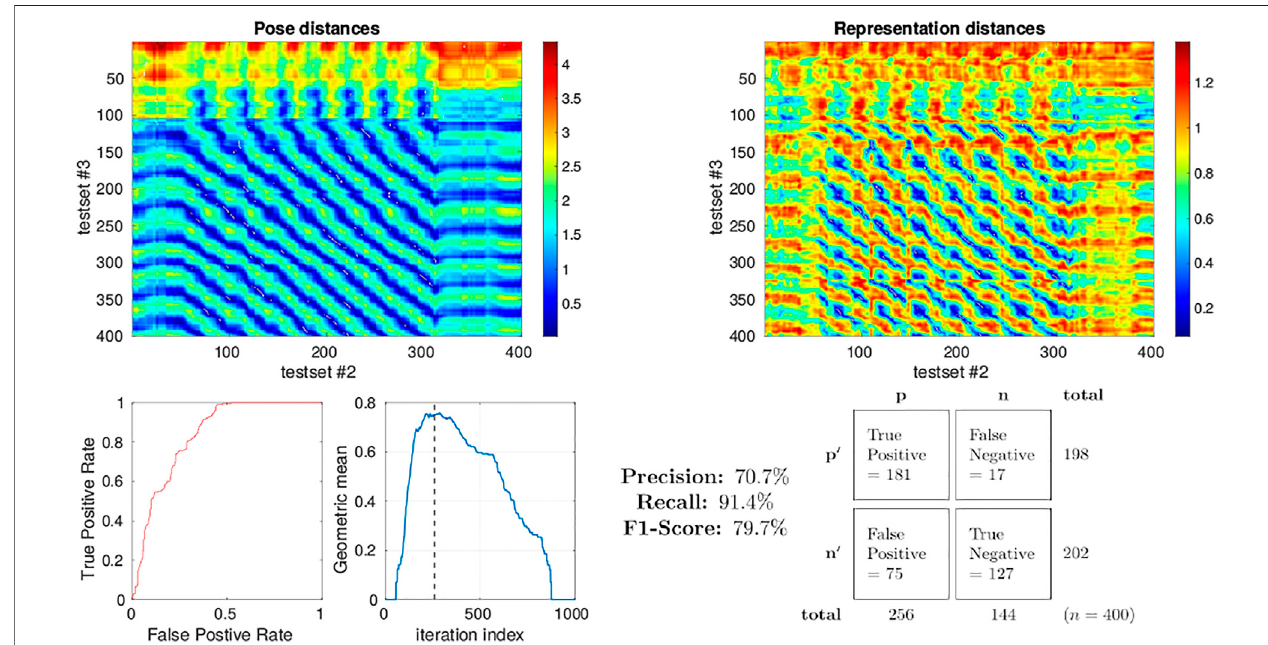
FIGURE11| Precision-recallcurve analysisappliedtosimulatedtest sets2and3(see Figure3 )classifyingforplacerecognitionthroughtherepresentation space of the trained MultiPredNet. Top left) Heatmap summarising the distance in pose space from each sample in test set 2 against each sample in test set 3. Top right) Heatmap ofdistances in representation spacebetween samples in test set 2against all samples in test set 3. White dots in the heatmap indicate classi fi cation points for each sample ( n (cid:1) 400) selected as the lowest distance in representation space between the 2 test sets. These points have been translated into the pose distance heatmap to determine a true or false classi fi cation. Lower left plot) Receiver Operating Characteristic (ROC) curve summarising impact of representation threshold for determining positive versus negative classi fi cations. Lower right plot) Geometric mean of the ROC curve at each threshold iteration with the peak highlighted by the verticaldashed line. Theconfusion matrix contains the summedclassi fi cation classeswhen using the optimal representation threshold determined fromROCcurve with the Precision, Recall and F1-Score for the classi fi er calculated from them.